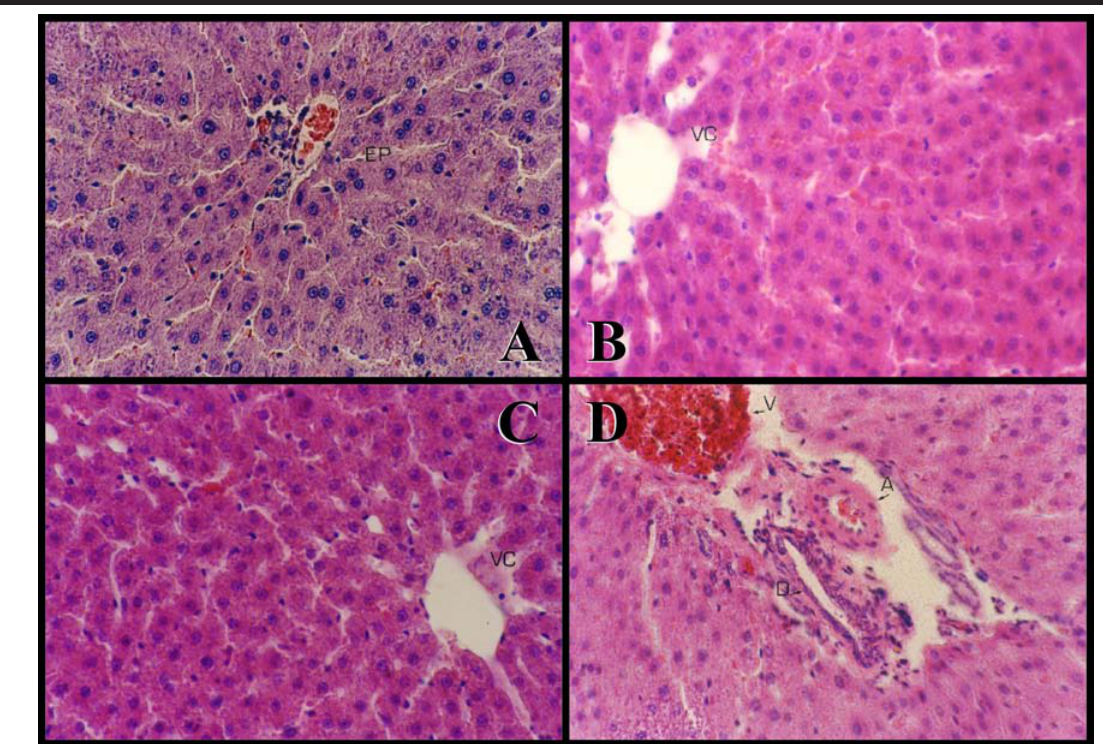
FIGURE 9 - Right lobe (procedure) microphotography of groups (A) A2 (14 days), (B) A3 (21 days), (C) A4 (28 days) e (D) A5 (60 days). It shows centrilobular vein (VC); portalspace (EP); artery (A); and duct (D). The presence of hepatocytes with one and two nucleus can be observed (40X